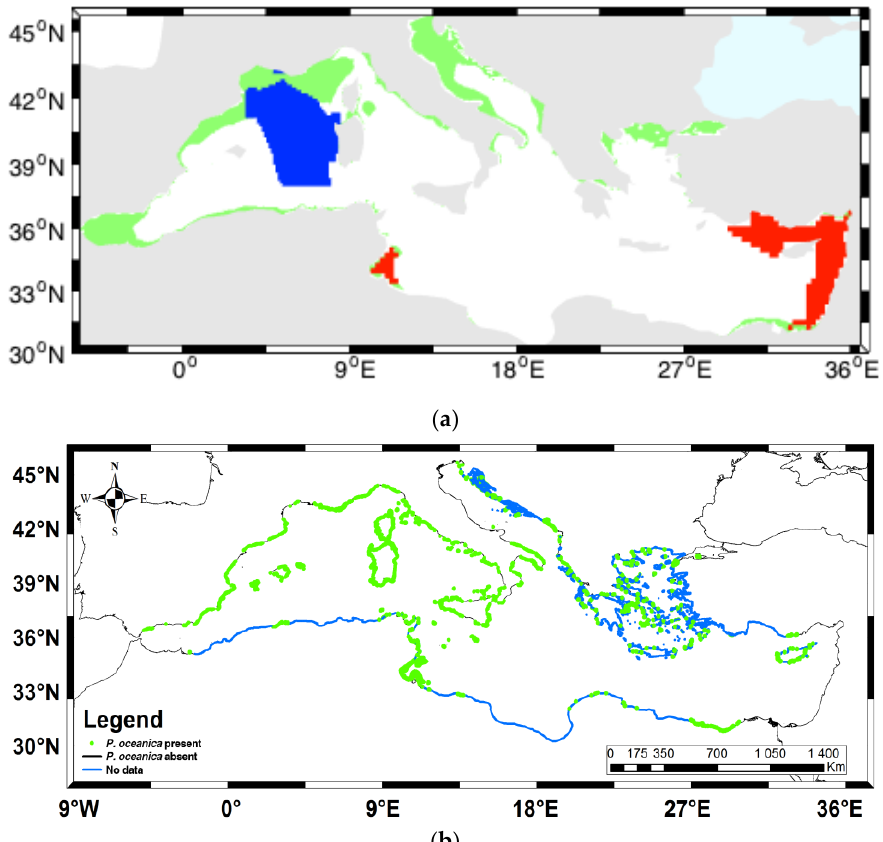
Figure 13. ( a ) Green colour: mean daily PAR at 15 m depth is less than 18 W/m 2 (about 80 μmoles/m 2 /s); blue colour: annual 95th SWH percentile averaged in 36 years is 2.8 m; red colour: annual 98th SST percentile averaged in 36 years is 27.9 °C; ( b ) Spatial distribution of P. oceanica meadows. Green colour indicates where P. oceanica presence was observed, black colour indicates where P. oceanica absence was documented and blue colour is for regions where there is lack of observations (based on [1]).